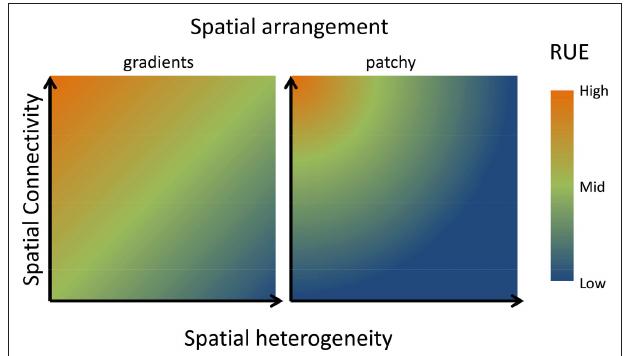
FIGURE 6 | Conceptual graph describing consequences of scaling up in space for RUE. If multiple resources are more heterogeneously distributed in space, RUE will decline unless high spatial connectivity (high rate of dispersal or active movement of consumer) allows efficient capture of multiple resources across the resource landscape (Hodapp et al., 2016). Thus, RUE will be minimal if resources are heterogeneously distributed, but low connectivity prevents consuming resources in different patches. The positive effect of dispersal or mobility decreases however, when neighboring patches differ strongly in their resource supply, reflected by the difference between a more gradual heterogeneity in the left panel compared to a more patchy difference in resource supply in the right panel. As detailed in the text, similar arguments can be made for temporal fluctuations in resource